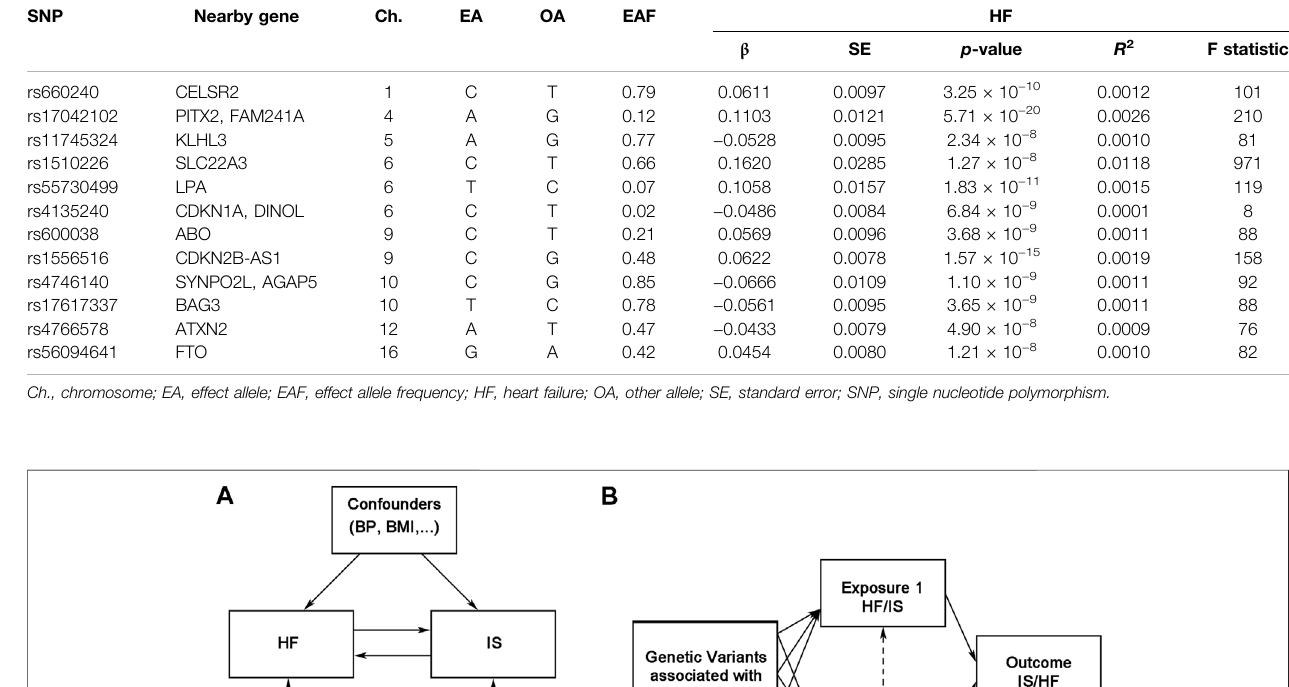
Frontiers in Genetics |